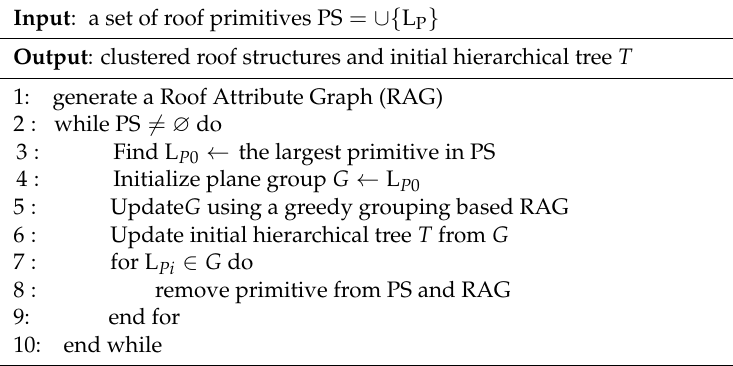
Table 1 . The details of the progressive decomposition and grouping algorithm. Table 1. The details of the progressive decomposition and grouping